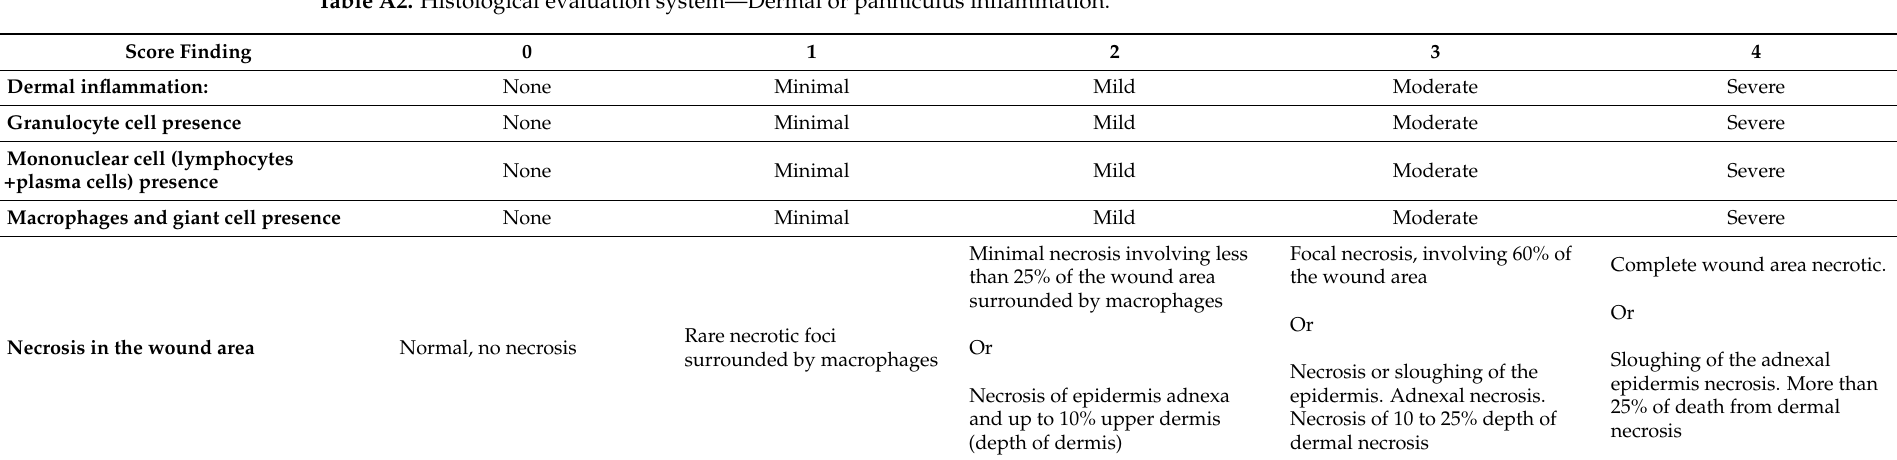
Table A2. Histological evaluation system—Dermal or panniculus